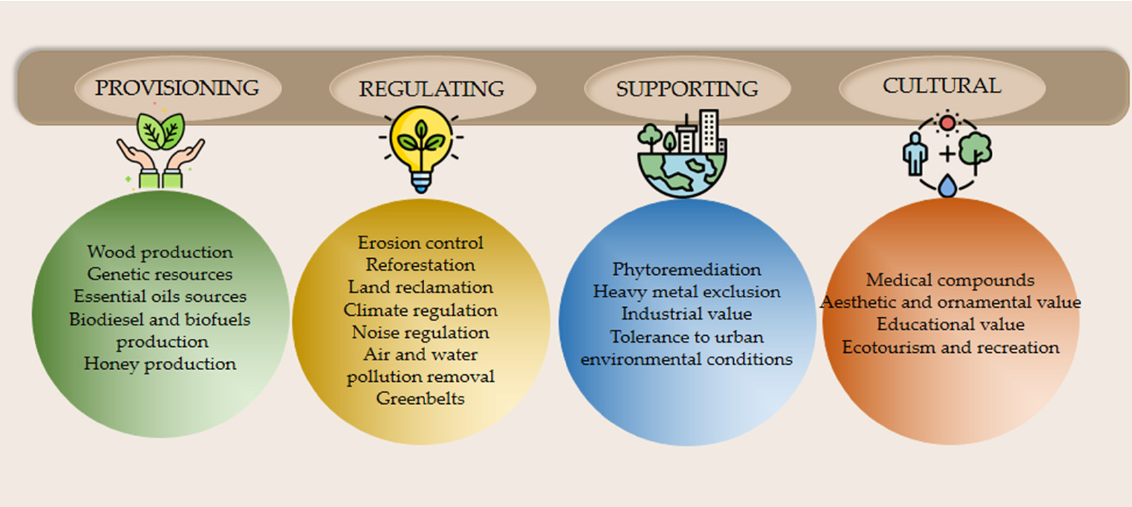
Figure 1. Most frequent ecosystem services of ornamental urban greenery, according to Puši ć et al. [25]. Reprinted by permission from Springer Nature Customer Service Centre GmbH: Springer Nature, Environmental Science and Pollution Research, Assessment and potential of ecosystem